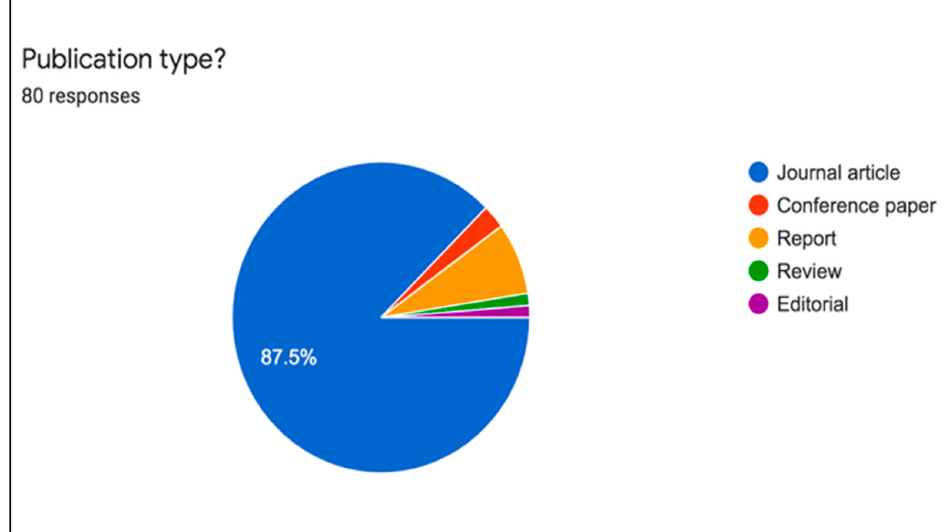
Figure 3. Type of publications reviewed.